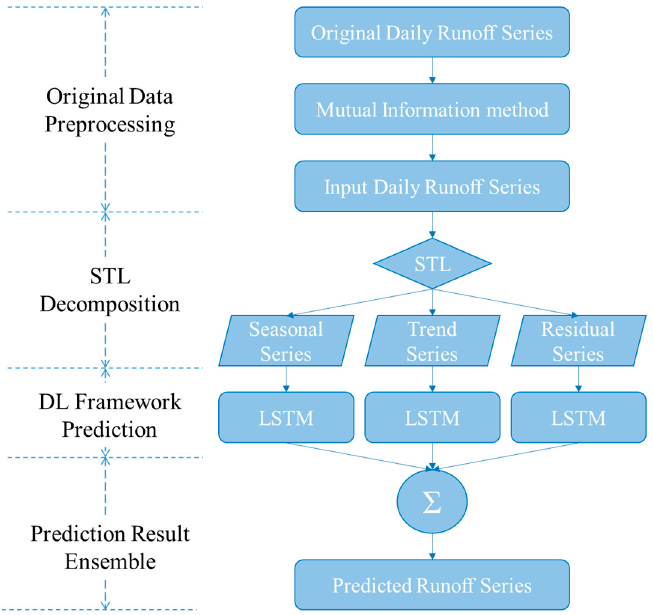
Figure 2. A flow chart of the proposed model, where STL for Seasonal and trend decomposition using Loess and DL for Deep